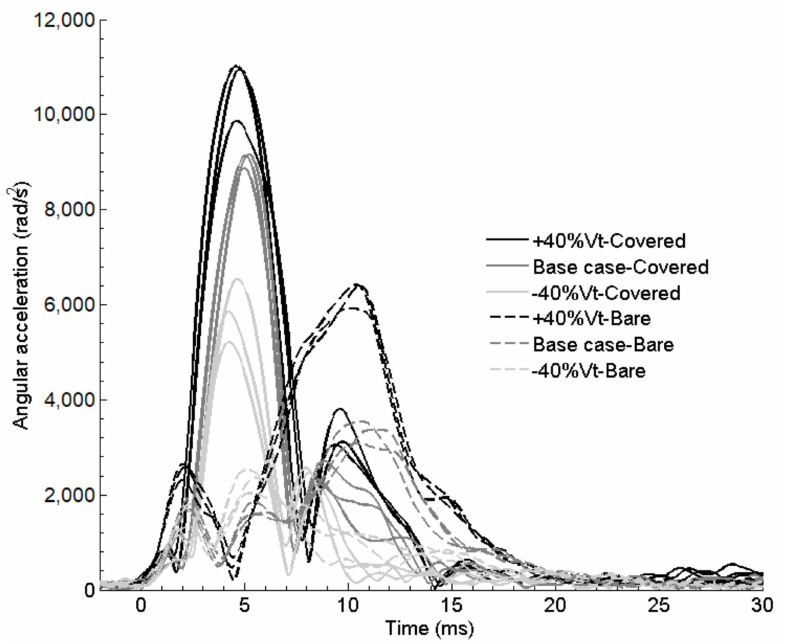
Figure 9. Resultant angular acceleration for the left side impacts. Solid lines correspond to covered headform and dashed lines correspond to bare headform